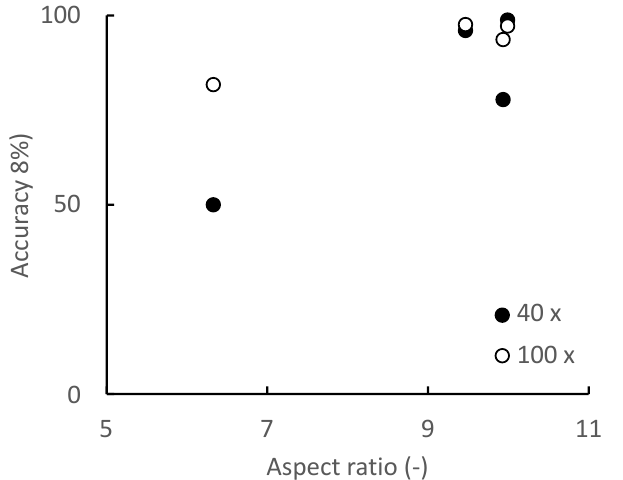
Figure 9. Relationship between the aspect ratio of cells and discrimination accuracy.